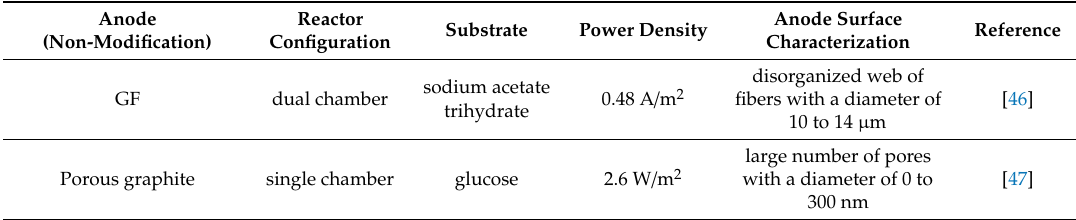
Table 1. Summary of carbon anode